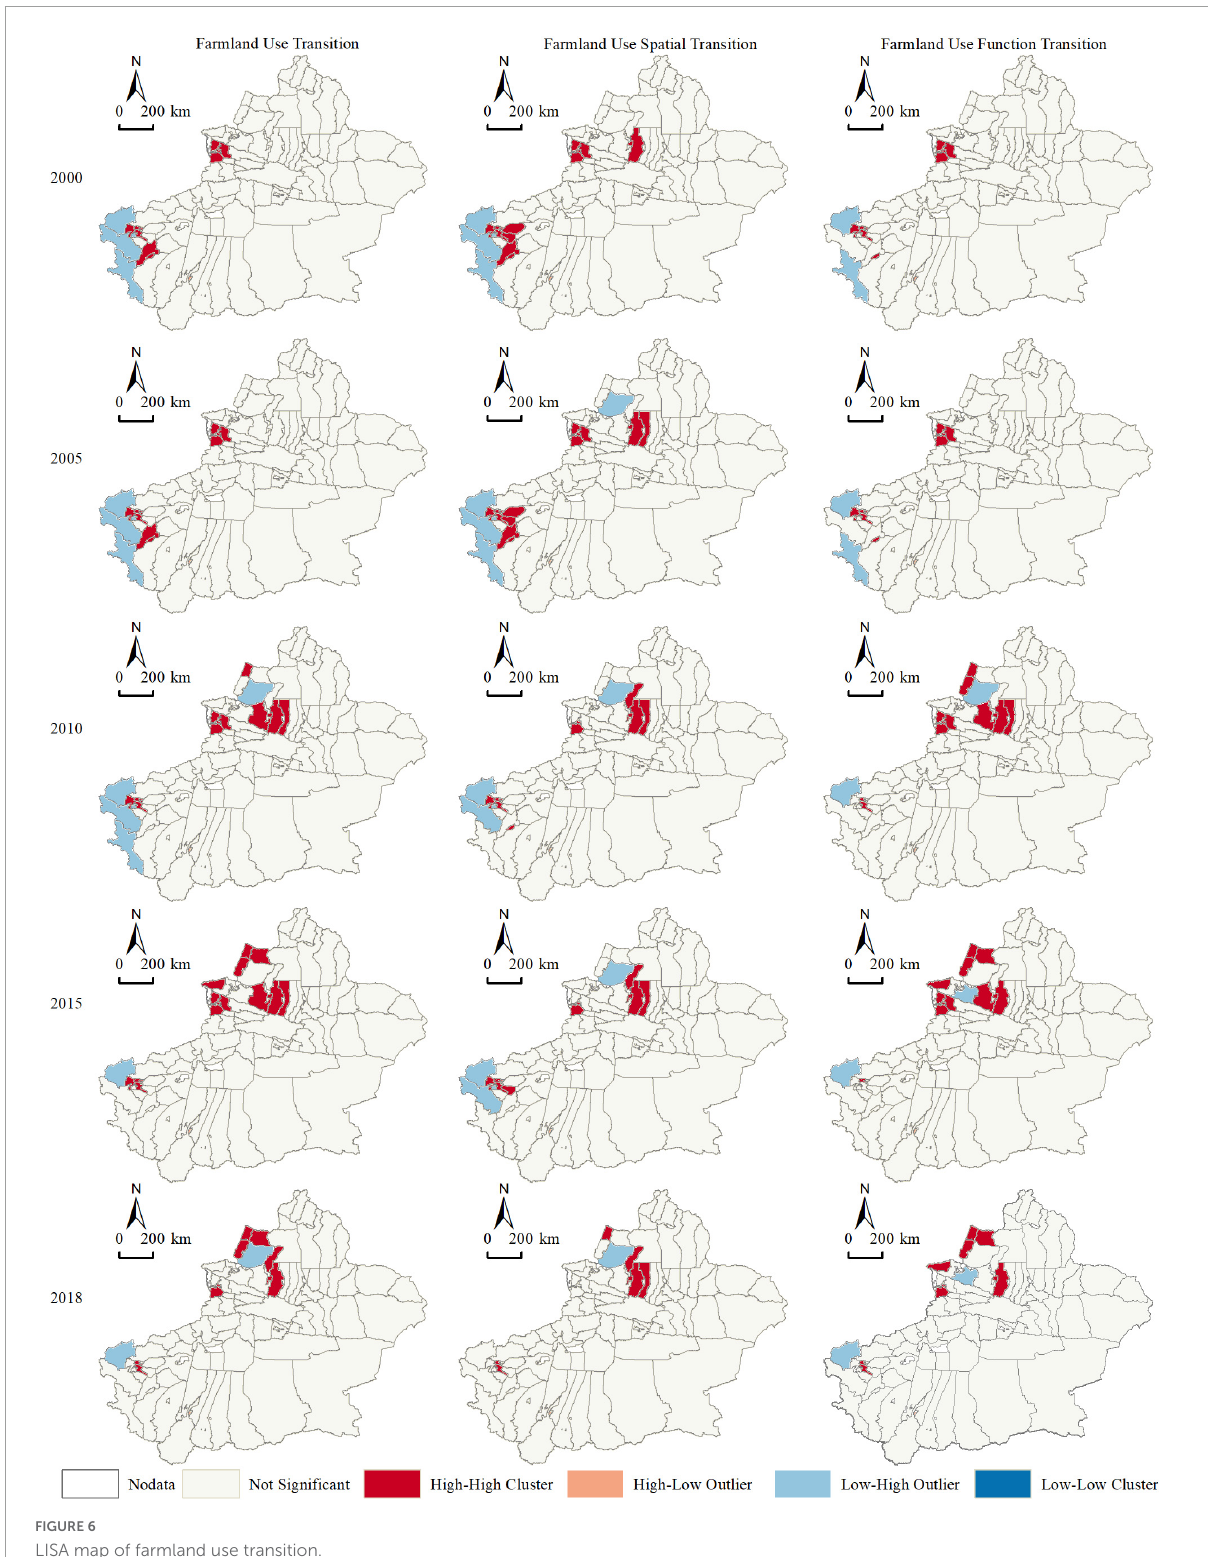
FIGURE6 LISA map of farmland use